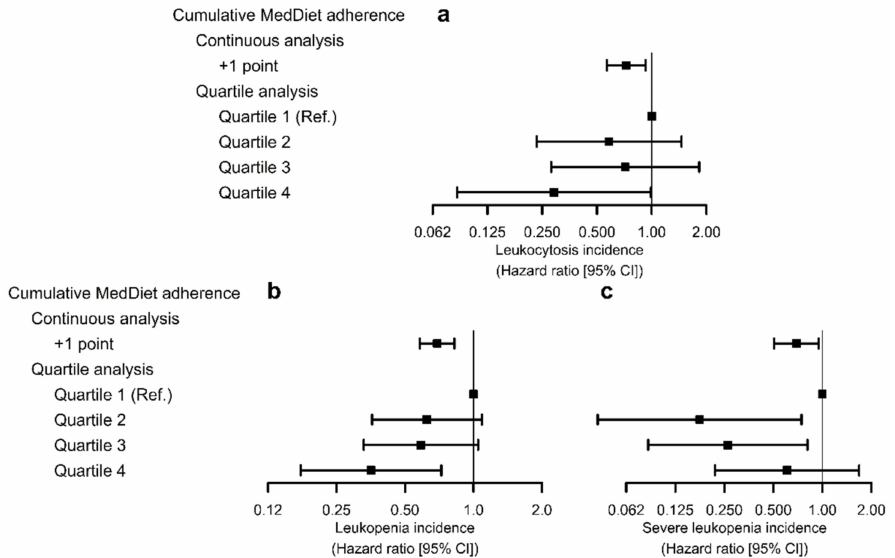
Figure 2. Associations of cumulative MedDiet adherence and risk of leukocytosis ( a ), leukopenia ( b ), and severe leukopenia ( c ). Hazard ratios were estimated by multivariable Cox regression models stratified by sex, recruitment site, and educational level, and adjusted for white blood cell count, age, diabetes, hypercholesterolemia, hypertriglyceridemia, hypertension, smoking habit, leisure-time physical activity, body mass index, hemoglobin levels, alcohol consumption (baseline values, all), and PREDIMED intervention group. We used robust standard errors to account for intra-cluster